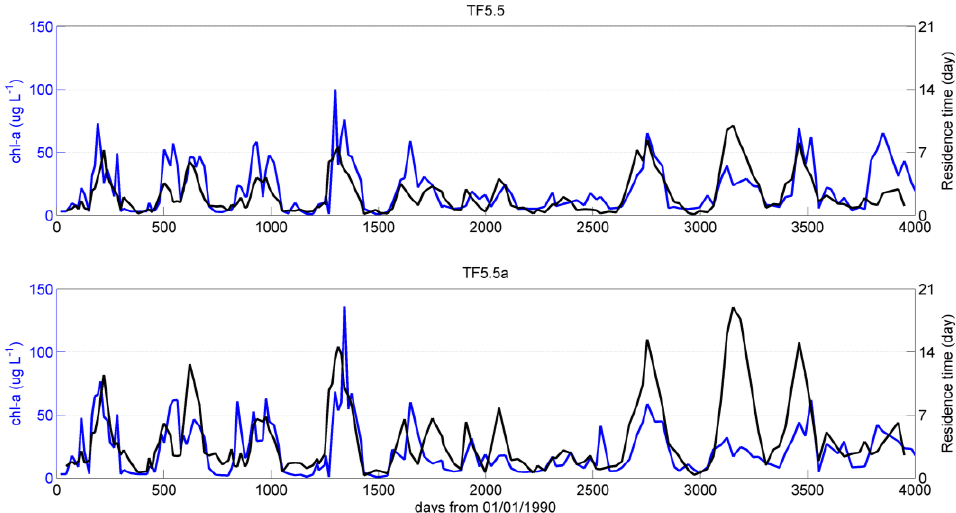
Figure 14. Comparison of residence time and Chl-a concentration at Stations TF5.5 and TF5.5a.